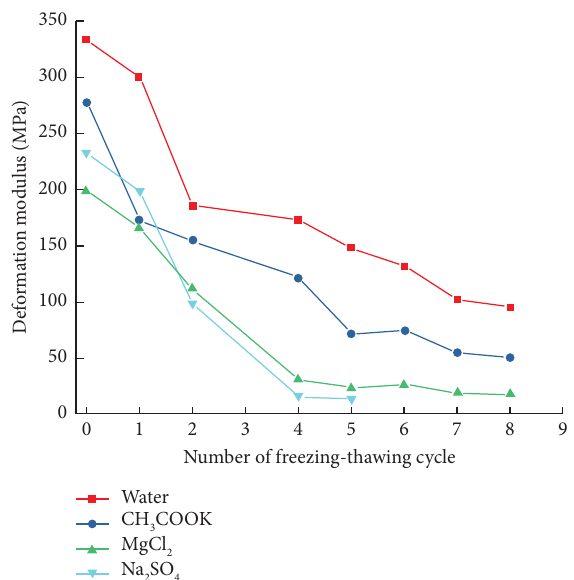
Figure 22: Relationship between the deformation modulus and the number of freezing-thawing cycles of the glass fber-reinforced cemented